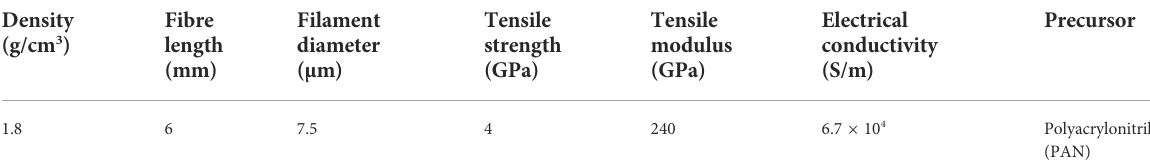
TABLE 1 Nominal properties of the chopped carbon fi bres from supplier.